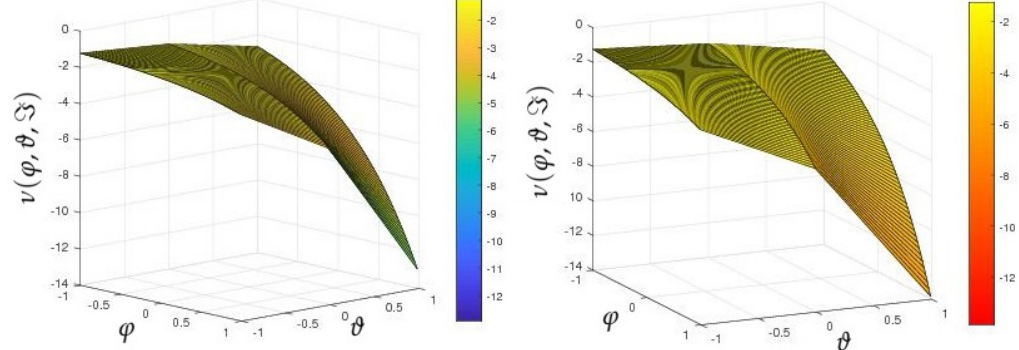
Figure 5. The HPTM graphs of δ = 1 and 0.8 of ν ( ϕ , ϑ ) Example 1.